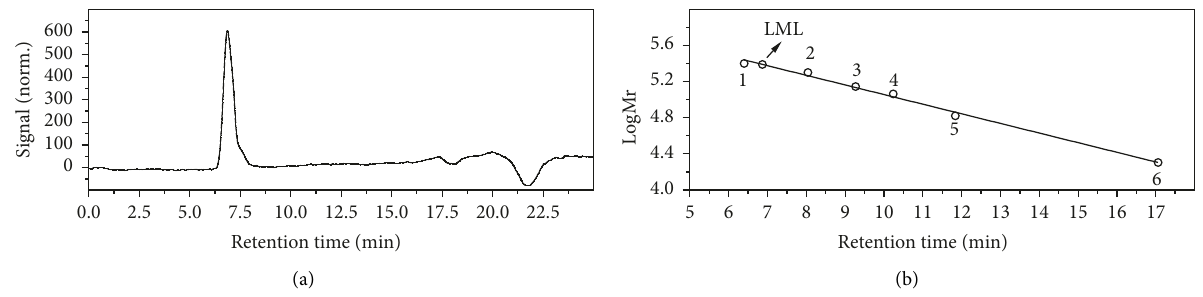
Figure 3: HP-GPC chromatogram of LML (a) and standard curve (b). Retention time of the standard reference proteins was plotted against the log molecular weight, and standards were as follows: 1, catalase (250 kDa); 2, myosin (200 kDa); 3, lactic dehydrogenase (140kDa); 4,